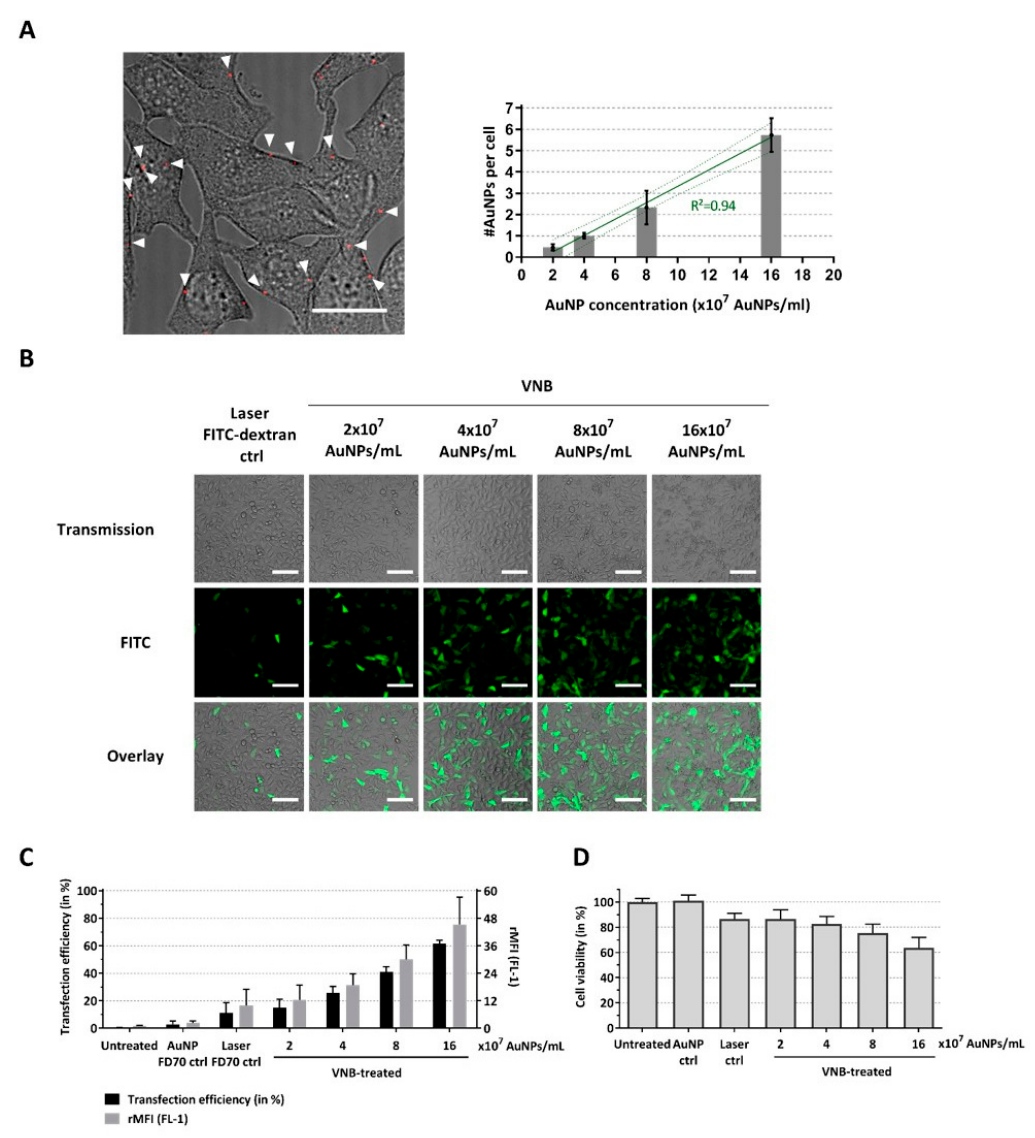
Figure 2. Delivery of FITC-dextran 70 kDa to B16 tumor cells by VNB photoporation. ( A ) B16 cells were incubated with different AuNP concentrations, after which, the excess of AuNPs was washed away. Left: Attachment of AuNPs (concentration: 8 × 10 7 AuNPs/mL) to the cells visualized by confocal reflection microscopy and overlayed with a light transmission image of the cells (scale bar = 20 µm). Right: The average number of cell-attached AuNPs was quantified for each of the AuNP concentrations using image processing (quantified from >100 cells for each condition). B16 cells were transfected with FITC-dextran 70 kDa (at 2 mg/mL) after incubation with different concentrations of gold nanoparticles (AuNPs). Untreated cells, cells incubated with AuNPs and FITC-dextran, and cells treated only with laser pulses (without AuNPs) were included as controls. ( B ) Confocal images of B16 cells after FITC-dextran delivery (scale bar = 100 µm). ( C ) FITC-dextran transfection efficiency as determined by flow cytometry ( n = 4, independent experiments). ( D ) Cell viability after photoporation treatment ( n = 3, independent